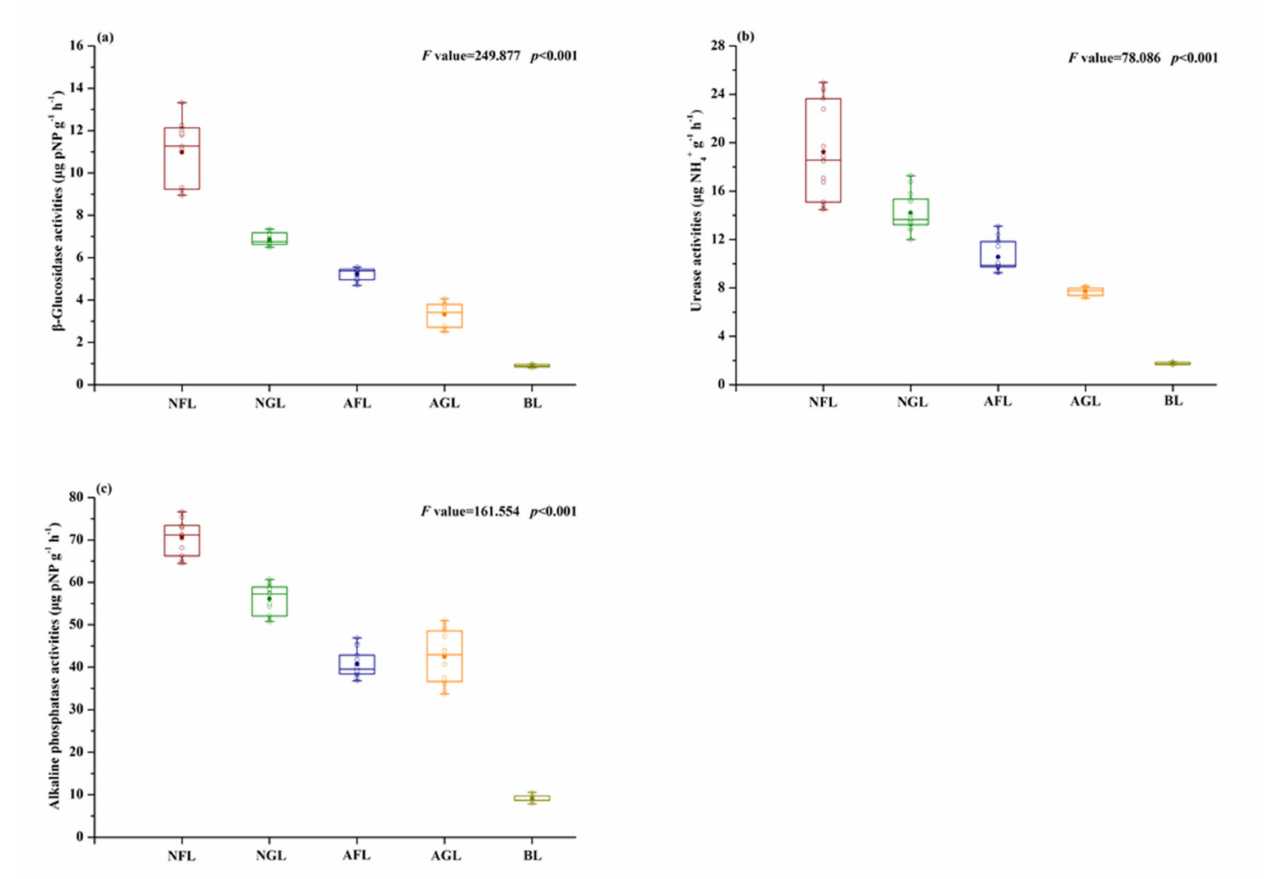
Figure 1. Soil enzyme activities under different vegetation restoration: ( a ) β - glucosidase, ( b ) urease, ( c ) alkaline phosphatase. The abbreviations of different vegetation restoration sites are as follows: NFL, natural forestland; NGL, natural grassland; AFL, artificial forestland; AGL, artificial grassland; BL, bare land. Solid circles indicate the median, hollow circles indicate the measured value ( n = 15 in four vegetation restoration sites and n = 5 in bare land). The line segments at the top and bottom represent the maximum and minimum values of the data,